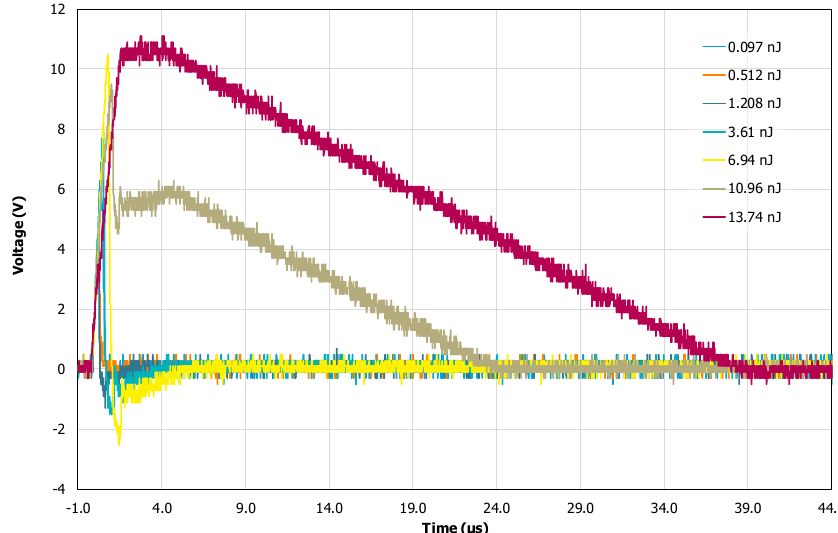
Figure 10. The response of the R1 to 1260 nm photons at different incident pulse energies. As can be seen from Figure 10, the transient voltage slope induced by TPA was very similar to that induced by SPA, and there was only a difference in the pulse laser energy.